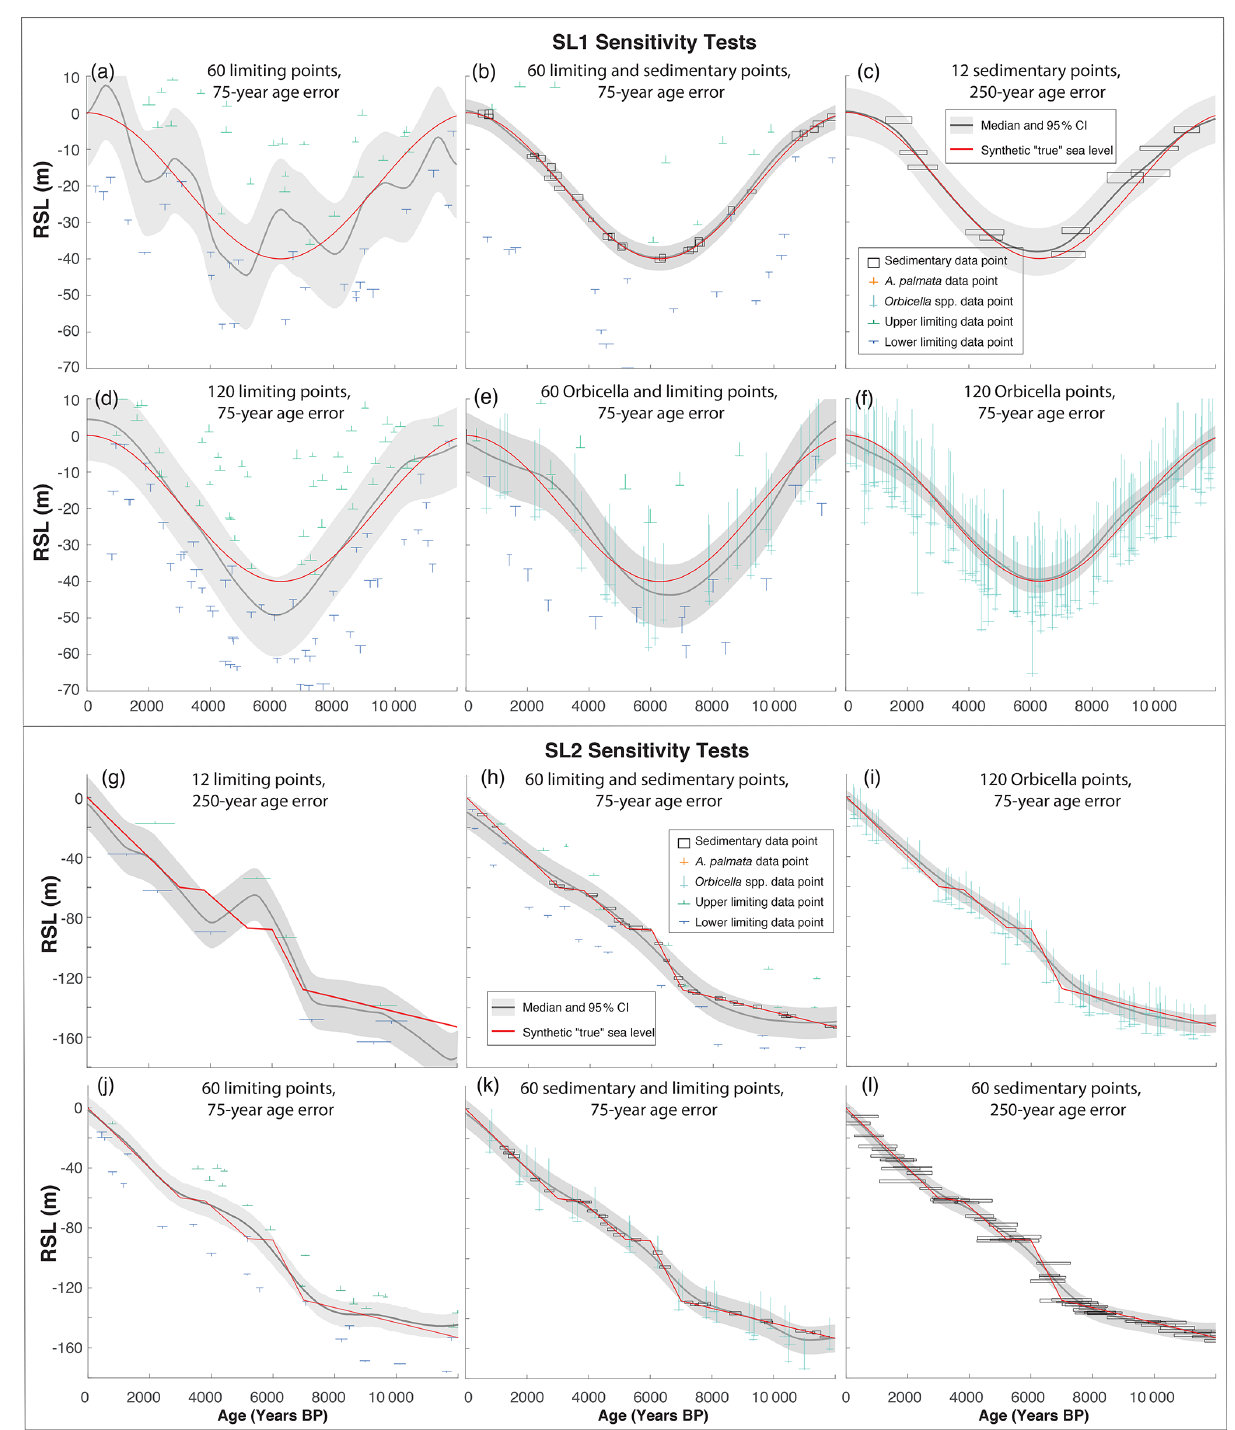
Figure 11. Twelve examples of sensitivity tests performed on “true” synthetic relative sea-level (RSL) curves: panels (a) – (e) show sea-level curve 1 (SL1), which represents rates of RSL change similar to the Holocene; panels (g) – (l) show sea-level curve 2 (SL2), which represents abrupt rates of RSL change and maximum rates of up to ∼ 40mkyr − 1 , similar to meltwater pulses. For both curves, the red line in each plot represents the synthetic truth. Each of these tests uses various combinations, quantities, and precision of data, which are labeled in each